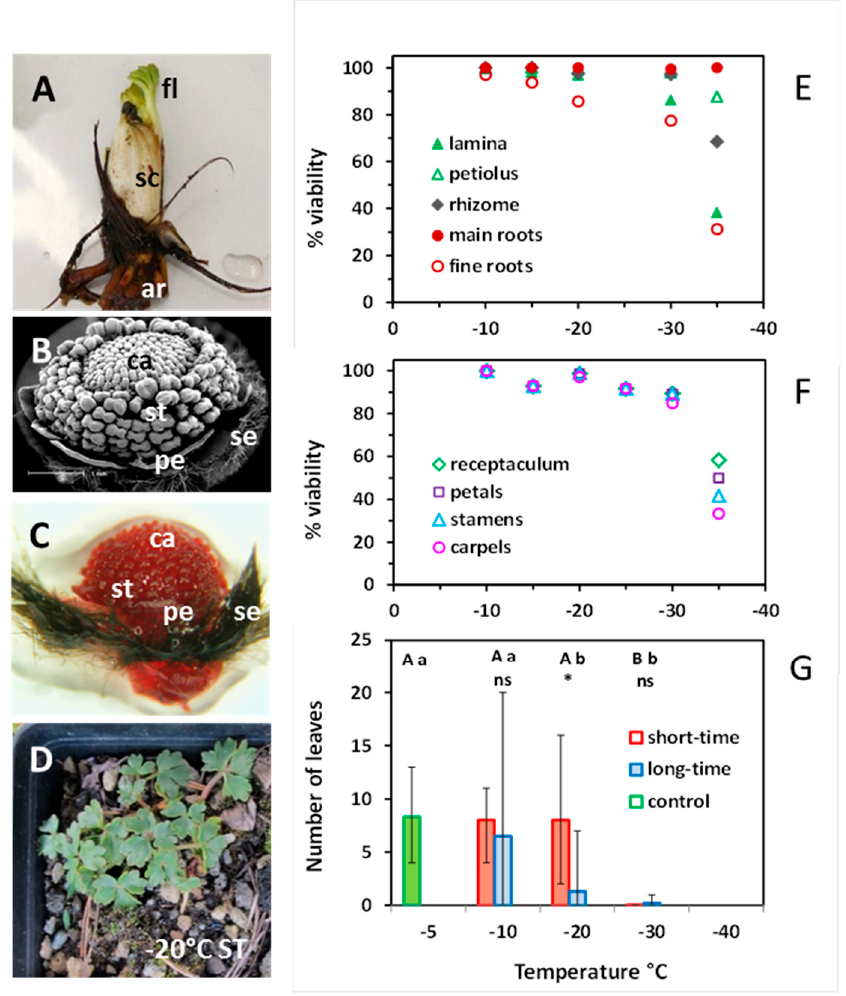
Figure 10. Ranunculus glacialis L. ( A ) Belowground winter bud with scale-like leaves (sc) enclosing foliage leaves (fl) and a determinate inflorescence (not visible from outside); foliage leaves started